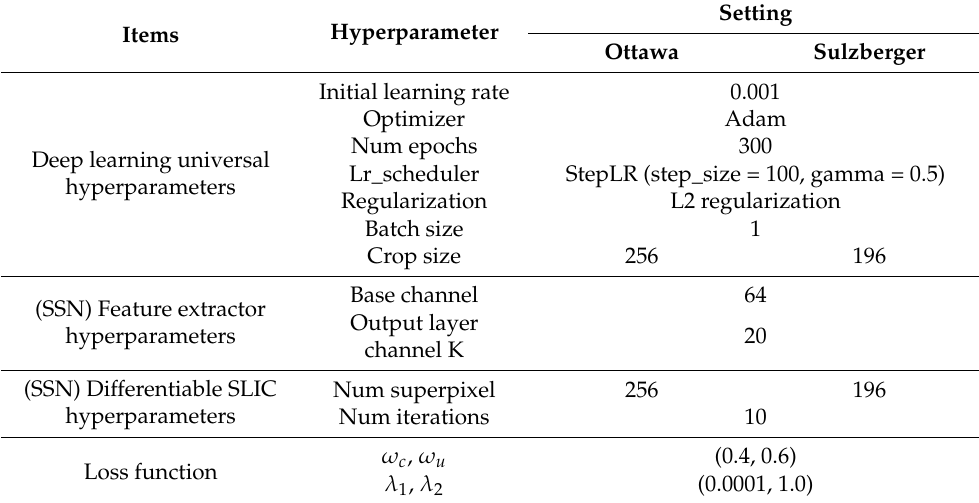
Table 2. Hyperparameter setting.